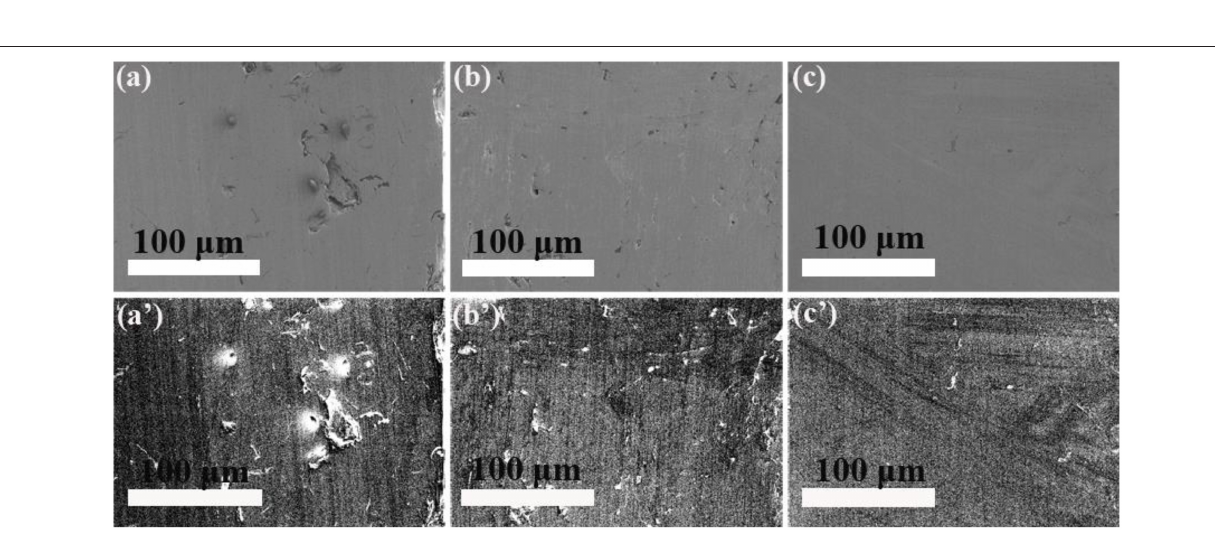
FIGURE 7 | Porosity estimation of NiCrAlY coating: (a,a ′ ) as-sprayed, (b,b ′ ) 900 ◦ C heat treatment, and (c,c ′ ) 1,100 ◦ C heat treatment.